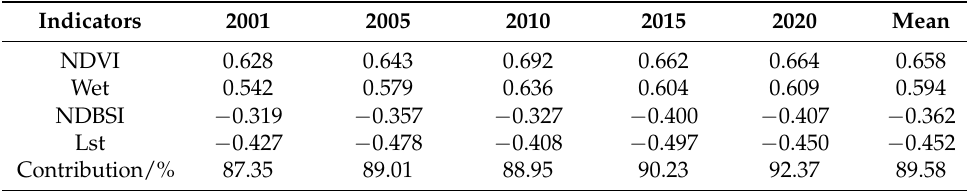
Table 2. Load values of RSEI indicators to the first principal